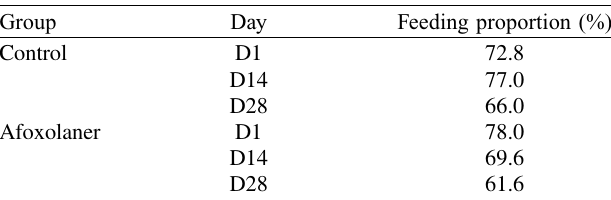
Mortality [%] = [(Total dead fed sand fl ies/Total collected fed sand fl ies) (cid:3) 100]. Table 3. Feeding proportion of female sand fl ies at 1 h post-